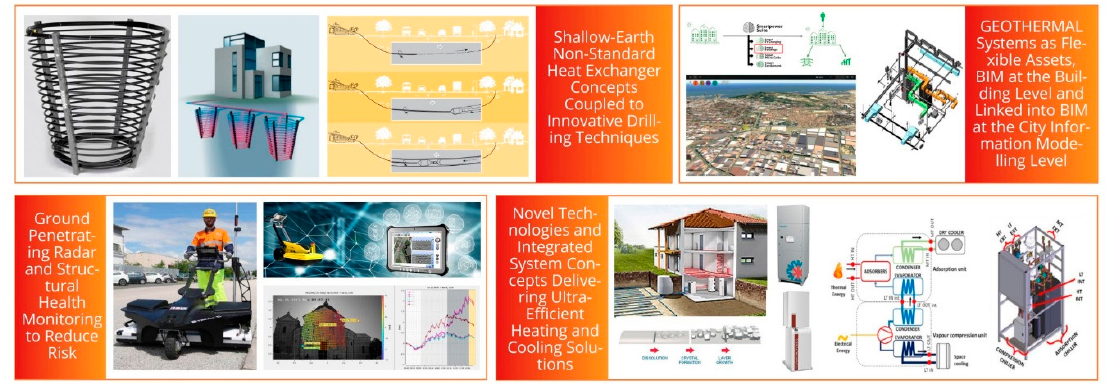
Figure 1. Research Pillars of GEOFIT.